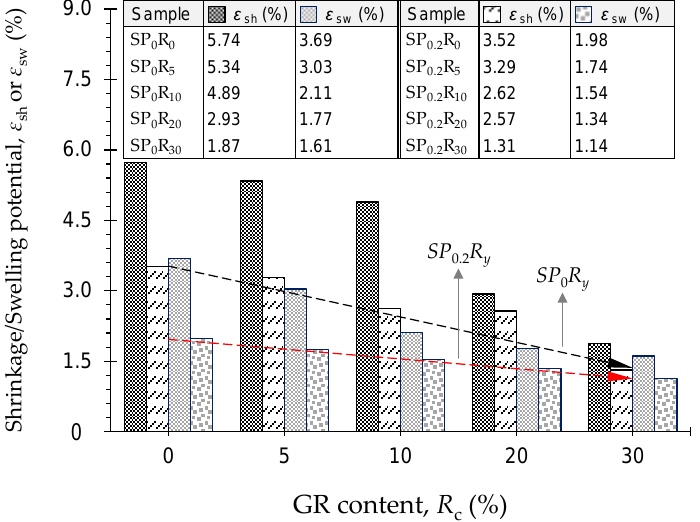
Figure 8. Variations of shrinkage and swelling potentials against GR content for the natural soil and various GR-blended samples— SP x R y where x = {0, 0.2}, and y = {0, 5, 10, 20,